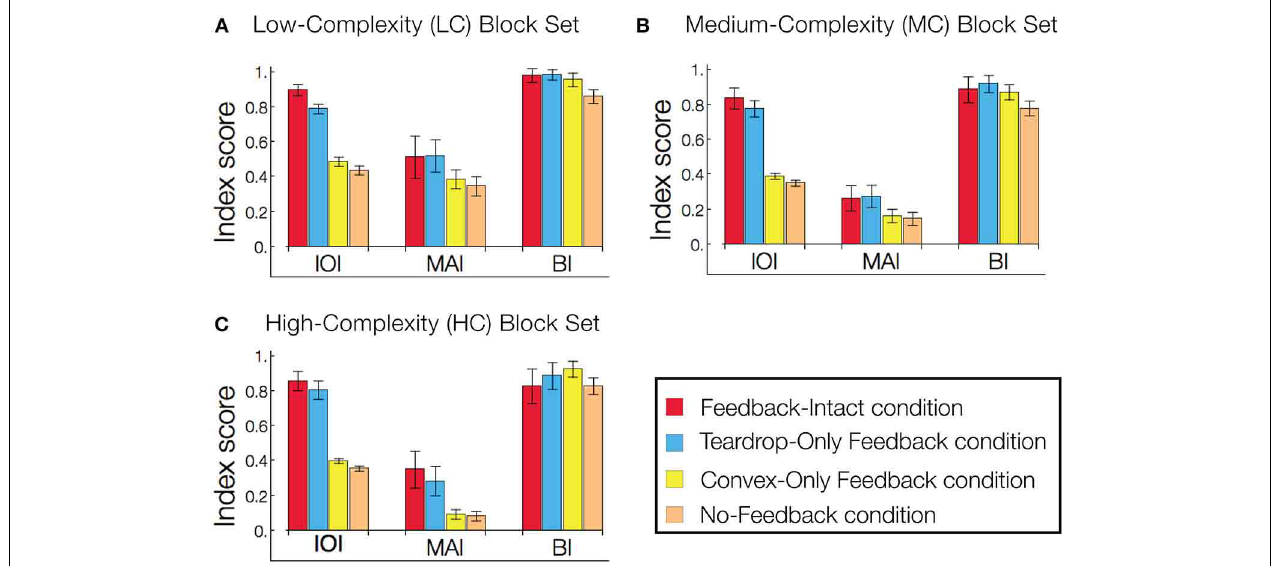
FIGURE 10 | Feedback greatly improves figure-ground segregation. Performance is expressed with respect to the IOI, MAI, and BI. The in-out index (IOI) assesses the proportion of convex cell responses are due to the figure rather than the background. The medial axis index (MAI) measures how concentrated convex cell responses are on the medial axis of the figure. The boundary index (BI) assesses how proportions of convex cell responses occur near the boundary of the figure, compared to other regions in the display. Performance in the low-complexity (A) , medium-complexity (B) , and high-complexity (C) block sets is expressed with respect to the IOI, MAI, and BI. All performance indices are normalized such that 1 indicates the best performance and 0 the worst. Each bar represents the mean index score across the entire visual display set, and the error bars correspond to ± 1 standard deviation. The indices are computed based on convex cell activity.